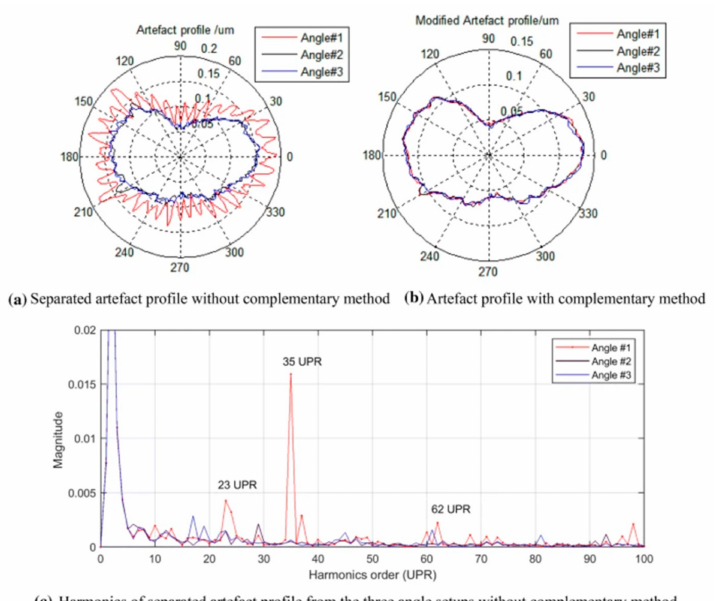
Figure 53. Harmonic suppression problem: separated artefact profile without complementary method ( a ), artefact profile with complementary method ( b ), harmonics of separated profile from the three angle setups without complementary method ( c ) [41].